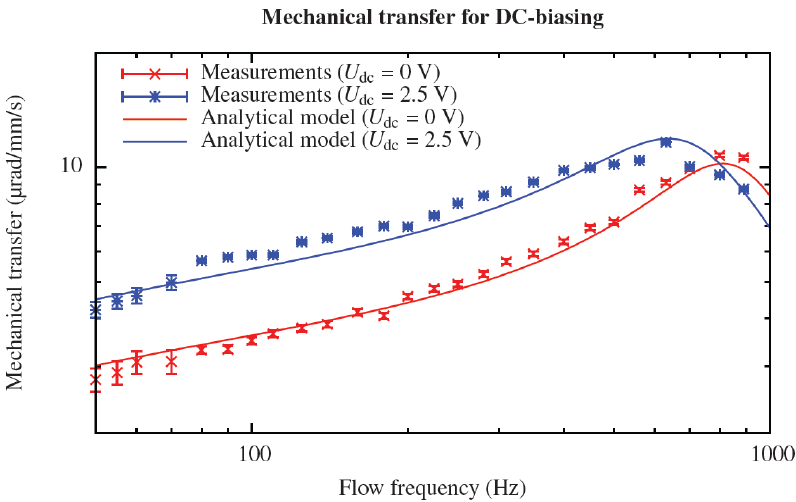
Figure 6. Enhancing the mechanical transfer of the hair flow sensor by applying a DC-bias